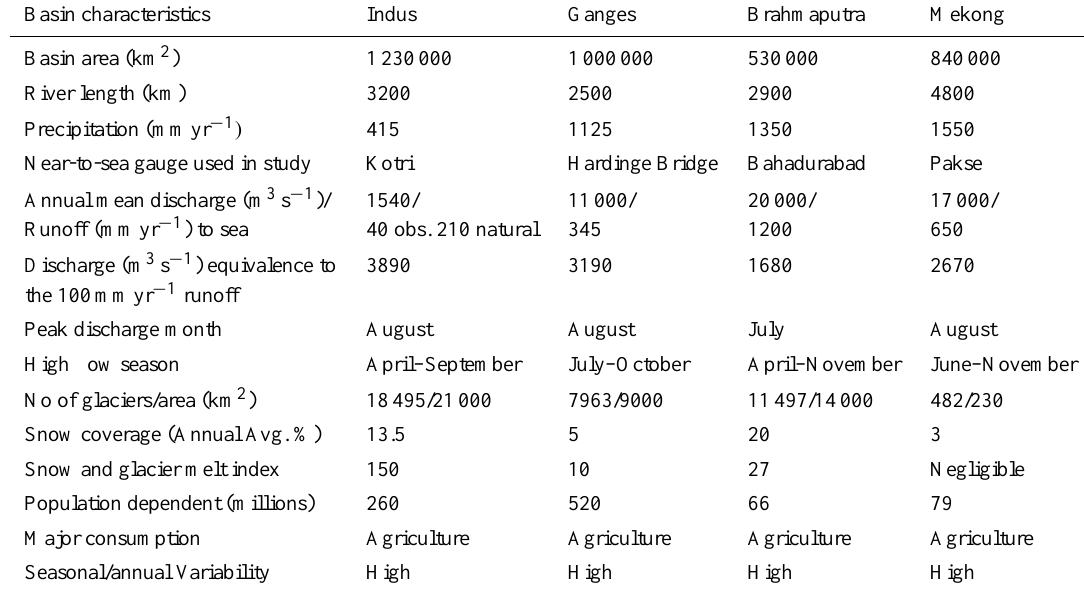
Table 1. Characteristics of the four studied river basins. Basin